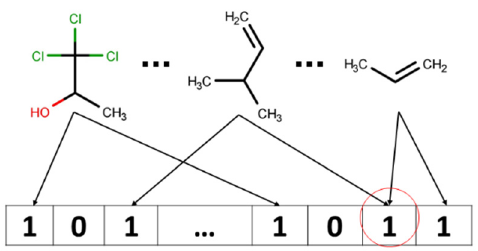
Figure 4. Possible bit collision: information about two fragments is encoded into the same bit.